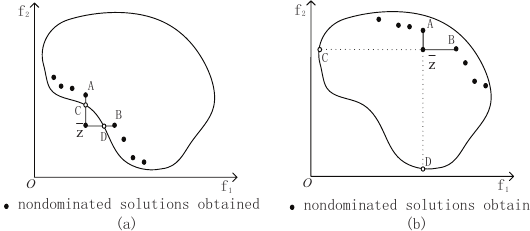
Fig. 2. Local search based on achievement scalarizing func- tion